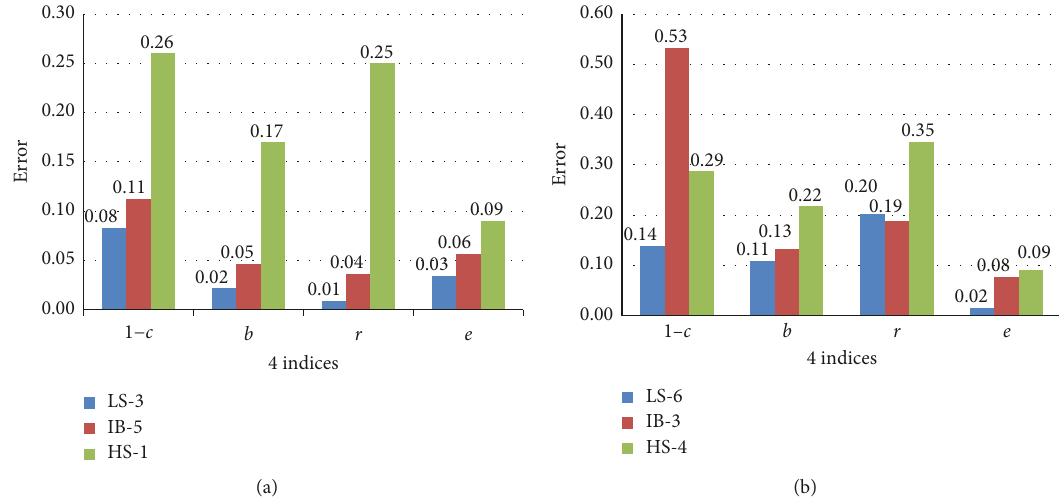
Figure 33: Comparison of shake table output error indices of several test cases. Test cases with (a) relatively small output error and (b) relatively big output error.